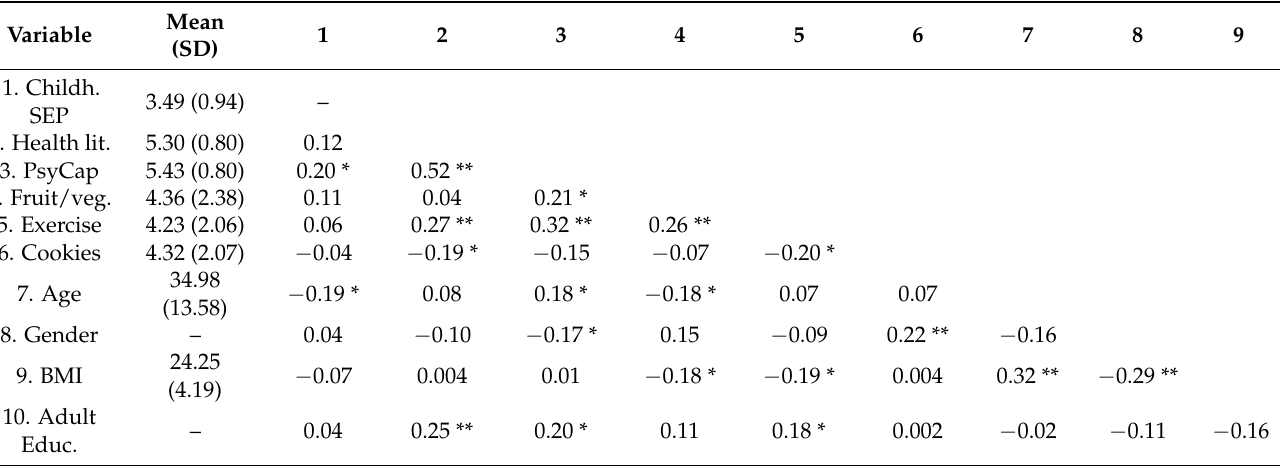
Table 1. Descriptives and correlations of variables included in the current research (n =